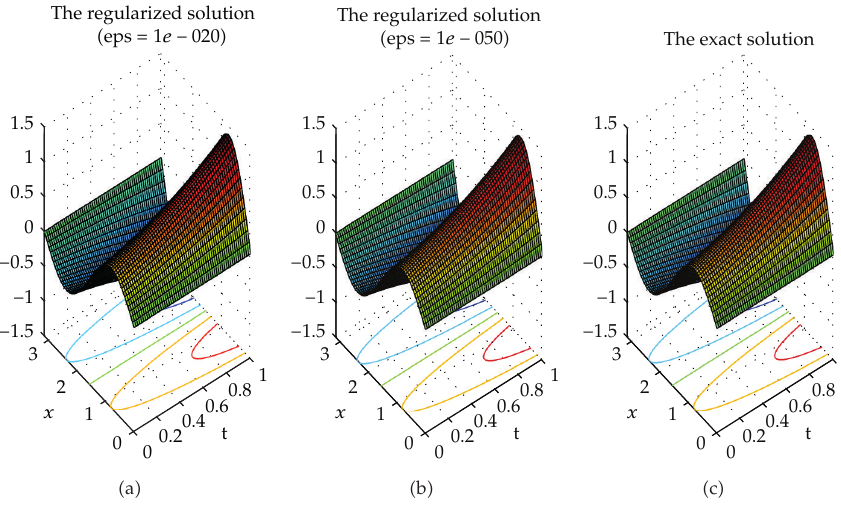
Figure 3: The regularized solutions corresponding δ i , i (cid:5) 7 , 8 and the exact solution.